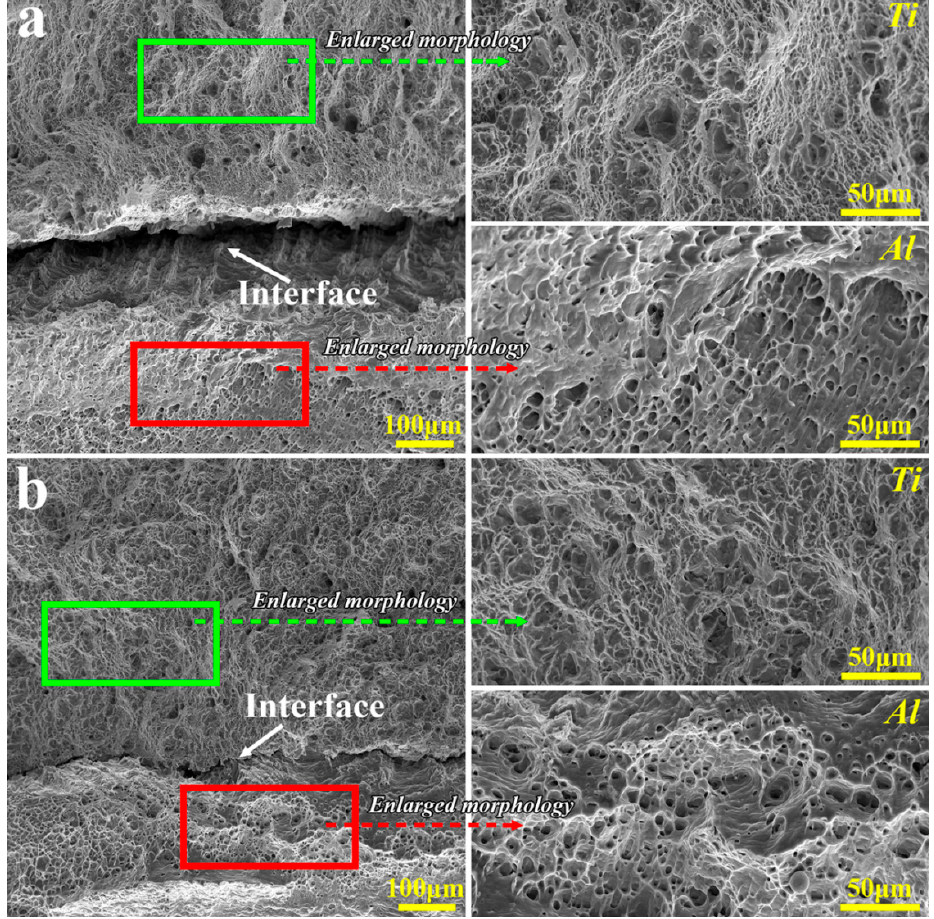
Figure 10. Fracture surfaces of annealed Al / Ti LMCs under the conditions of ( a ) conventional process and ( b ) D550. Right images are the magnification of selected zone in left images observed in Al and Ti layers, respectively.